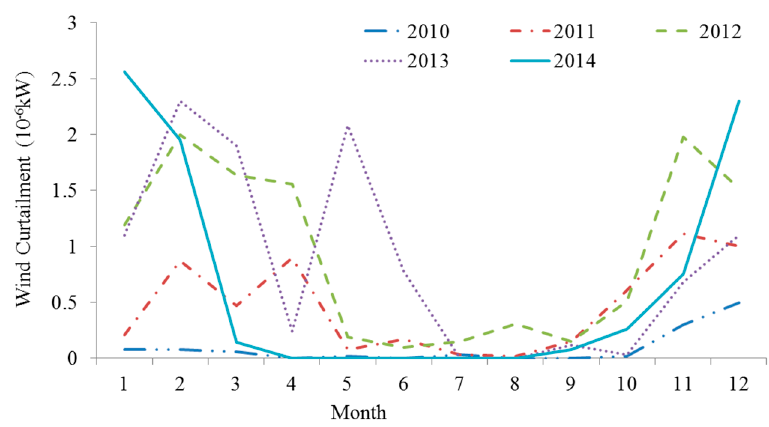
Figure 4. The wind curtailment situation of the provincial power grid.